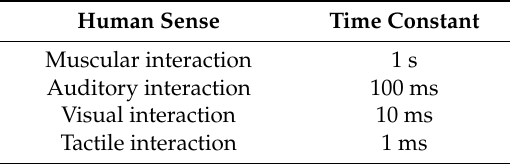
Table 2. Physiological time constant of different human